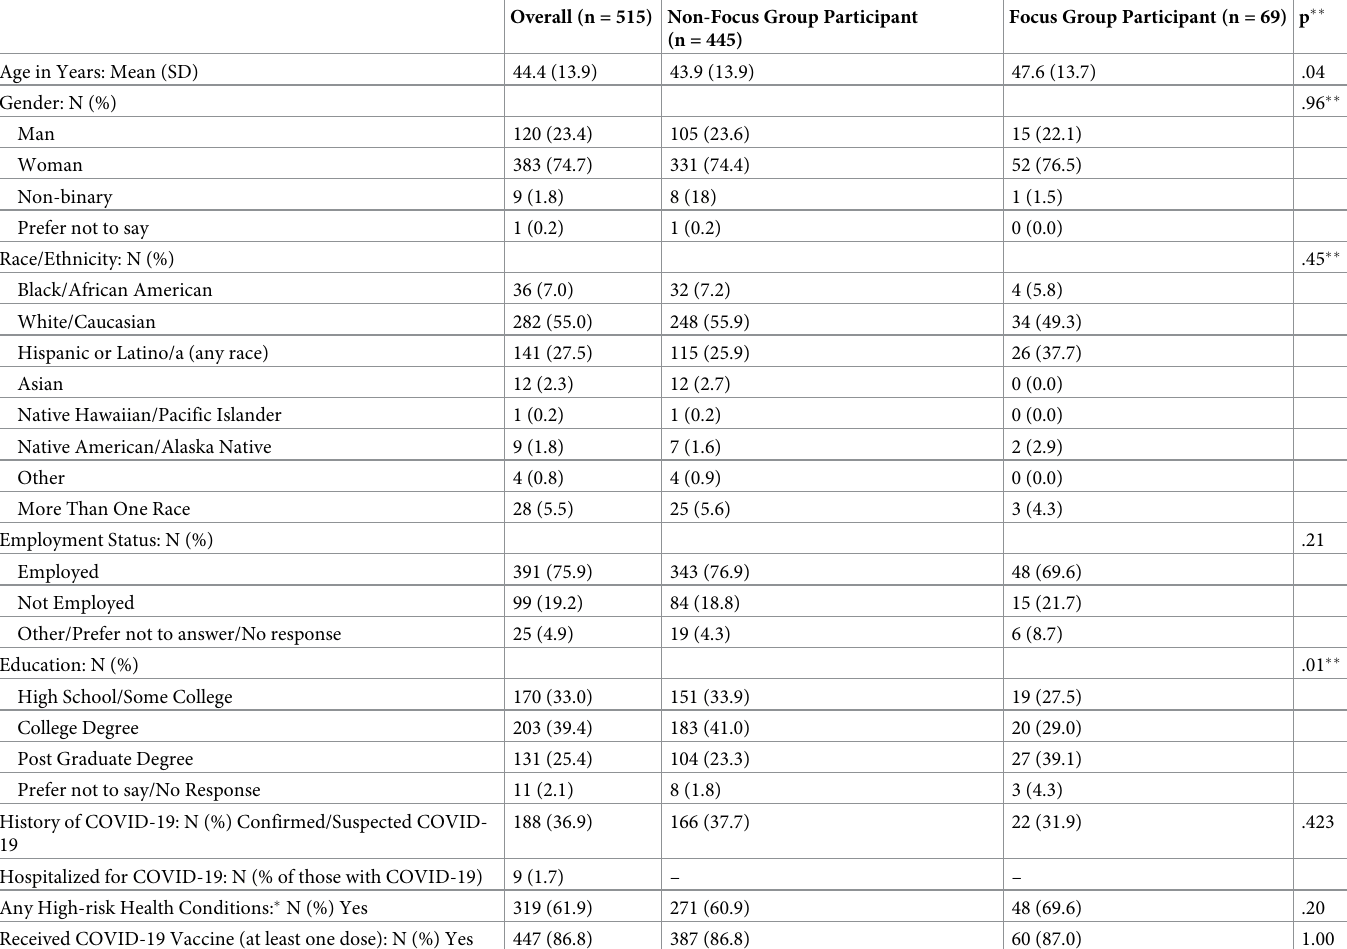
Table 1. Participant